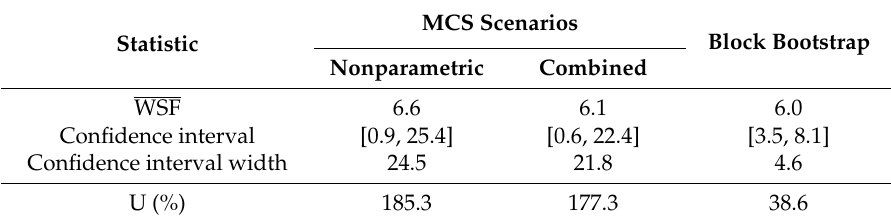
Table 3. The statistical values of the water scarcity footprint for the rice production (unit: m 3 world-eq